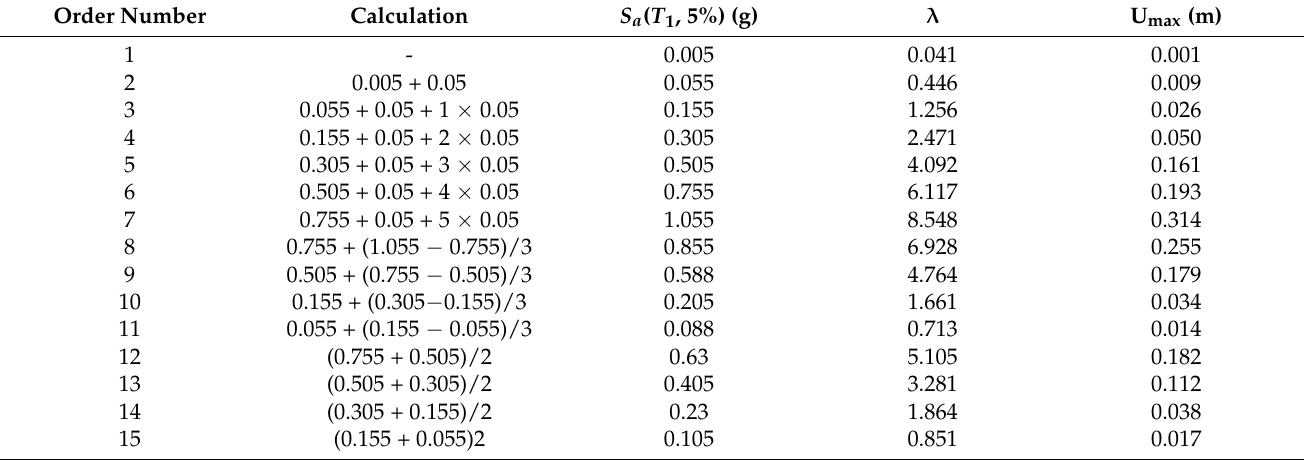
Table 6. Amplitude modulation calculation